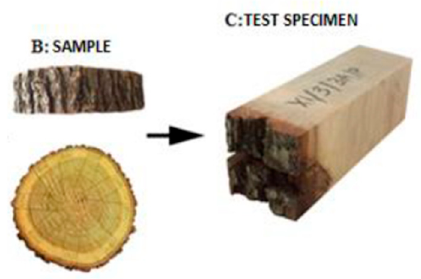
Figure 2. Sequential steps to obtain the samples for testing the shear strength.